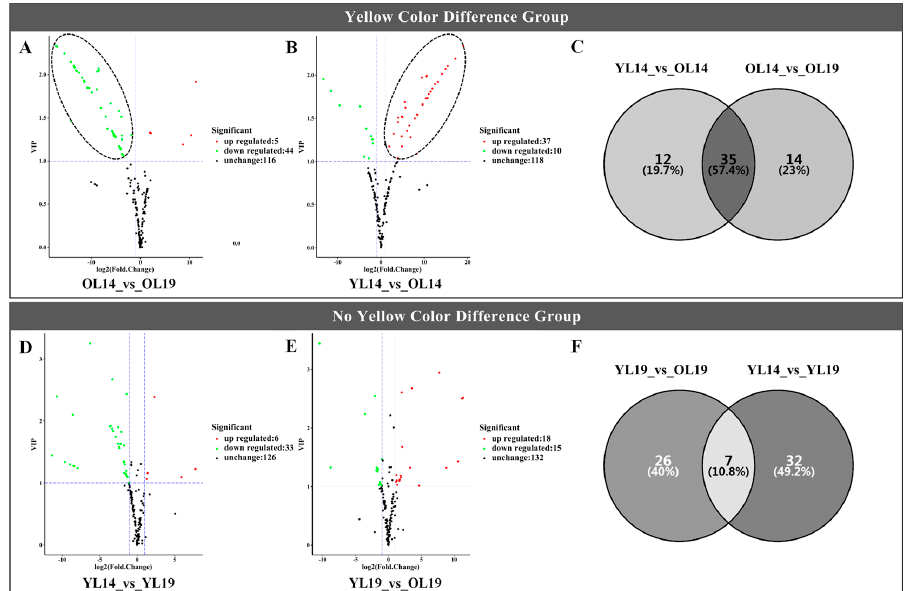
Figure 3. The metabolite volcano diagram and Wayne diagram. ( A , B , D , E ) The volcano map showed the difference in the expression level of metabolites in the four groups of samples, and the difference was statistically significant. The ( C , F ) Venn diagram depicts the common and unique number of (shared and unique) DAF among the four groups of samples, respectively. (shared and unique) DAF among the four groups of samples,